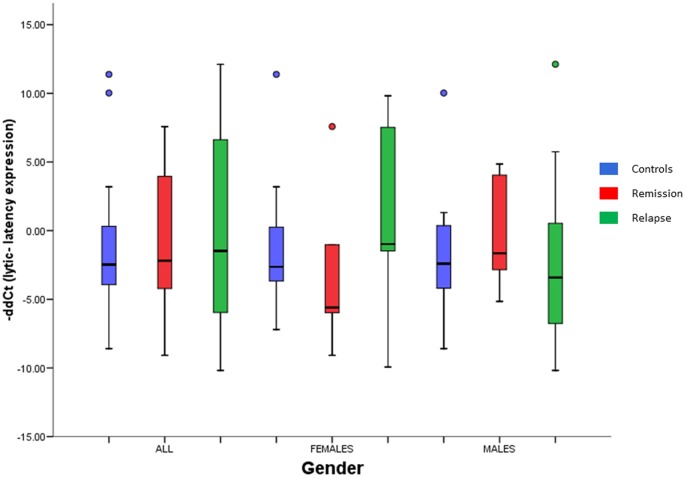
Viral gene expression of the EBV in peripheral blood leukocytes.-ddCts of lytic vs. latency gene expression were obtained from –dCts of BZLF1 expression (lytic expression) and the mean –dCts of the 4 latency genes (EBNA1, EBNA2, LMP1 and LMP2; latency expression). -ddCt >0: higher lytic expression; -ddCt <0: higher latency expression. None of the differences between conditions (controls, patients in remission, patients in relapse) were statistically significant at p<0.05 in none of the groups (all samples, female subjects and male subjects).